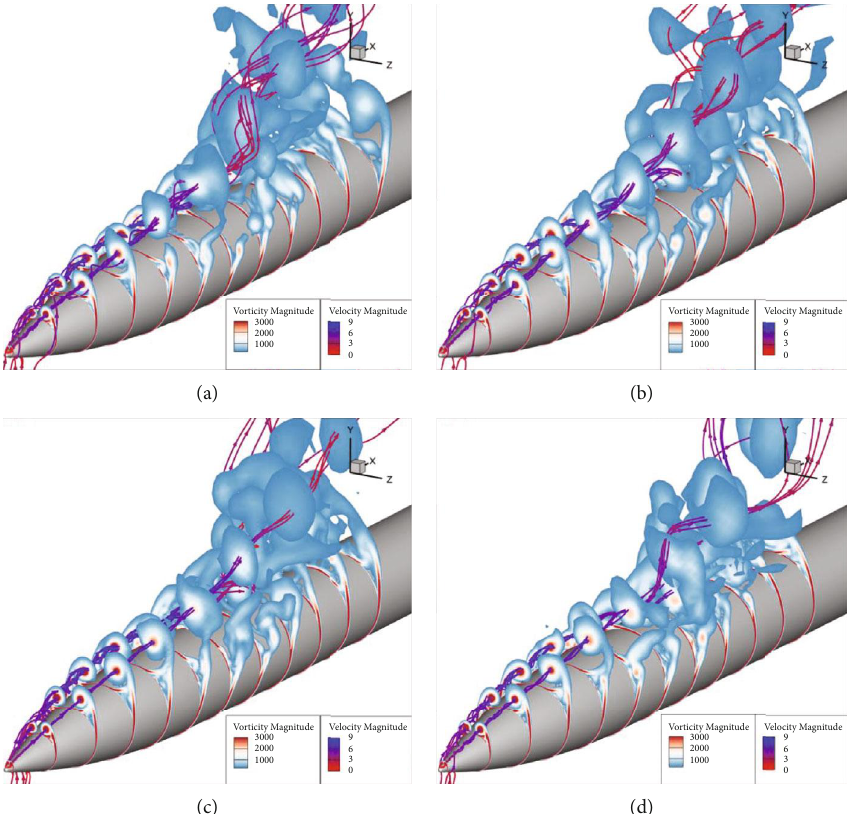
Figure 23: Comparison of vorticity and streamline on the right side with di ff erent values of roughness: (a) Model 1, (b) Model 2, (c) Model 3, and (d) Model